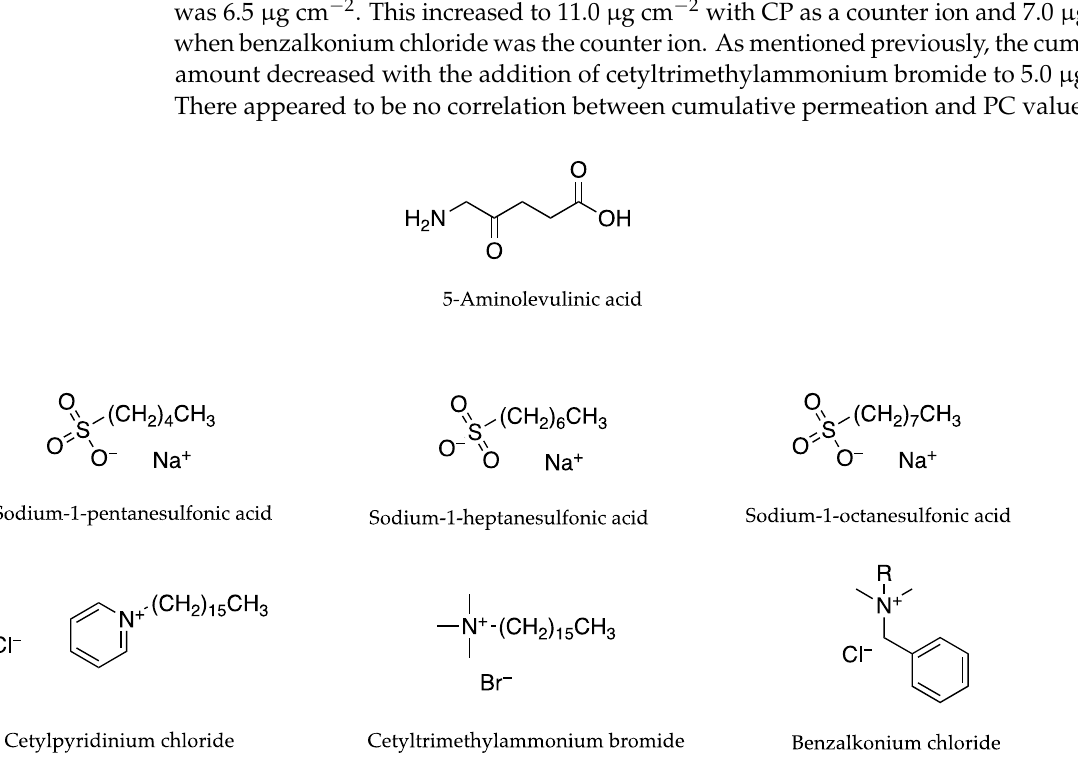
Figure 7. ALA and counter ions: sodium-1-pentanesulfonic acid, sodium-1-heptanesulfonic acid, sodium-1-octanesulfonic acid, cetylpyridinium chloride, cetyltrimethylammonium bromide and benzalkonium chloride. Table 6. PC and cumulative amount permeated of pure ALA and in conjunction with various counter ions at pH 4.0 and pH 7.0. The concentration of ALA applied in the buffer solutions was 0.4 mg mL − 1 (for permeation experiments n ≥ 3, values represent the mean ± S.D.) Adapted with permission from [36], Elsevier,